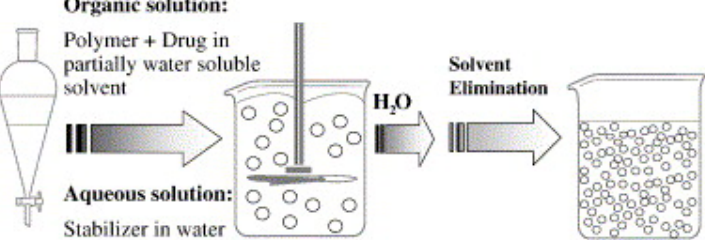
Figure 9. Schematic representation of the emulsification/solvent diffusion technique. Reprinted with permission from Reference [53]. Copyright 2006 Elsevier.